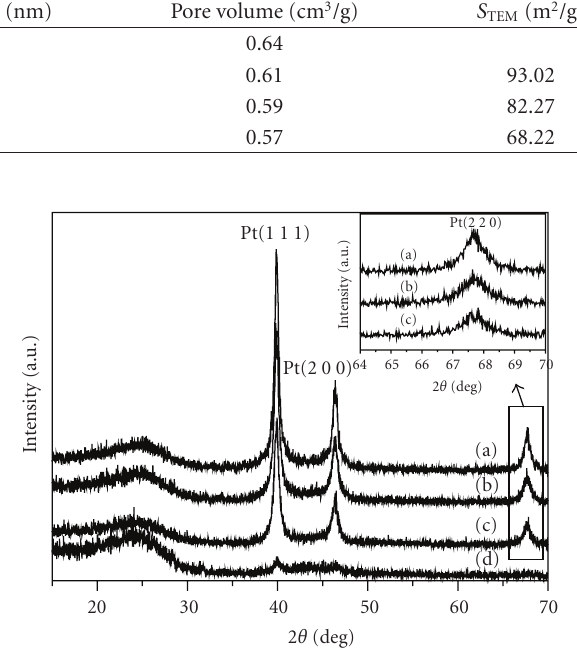
Figure 3: XRD patterns of MC (d), 0.5-Pt/MC (c), 1-Pt/MC (b), and 2-Pt/MC (a) samples. The inset is the detail scan of Pt(2 2 0) peaks for Pt/MC